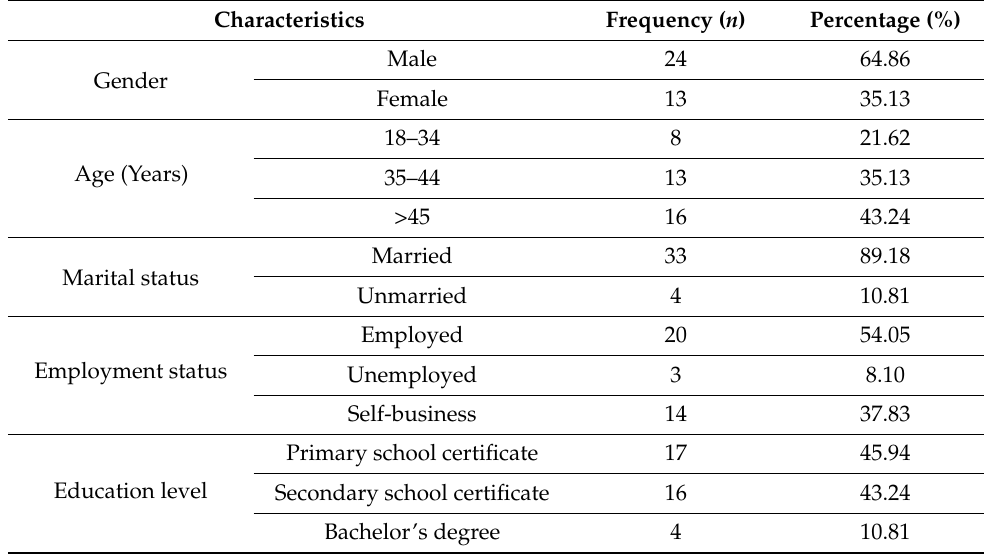
Table 2. The demographic characteristics of studied HIV patients ( n =